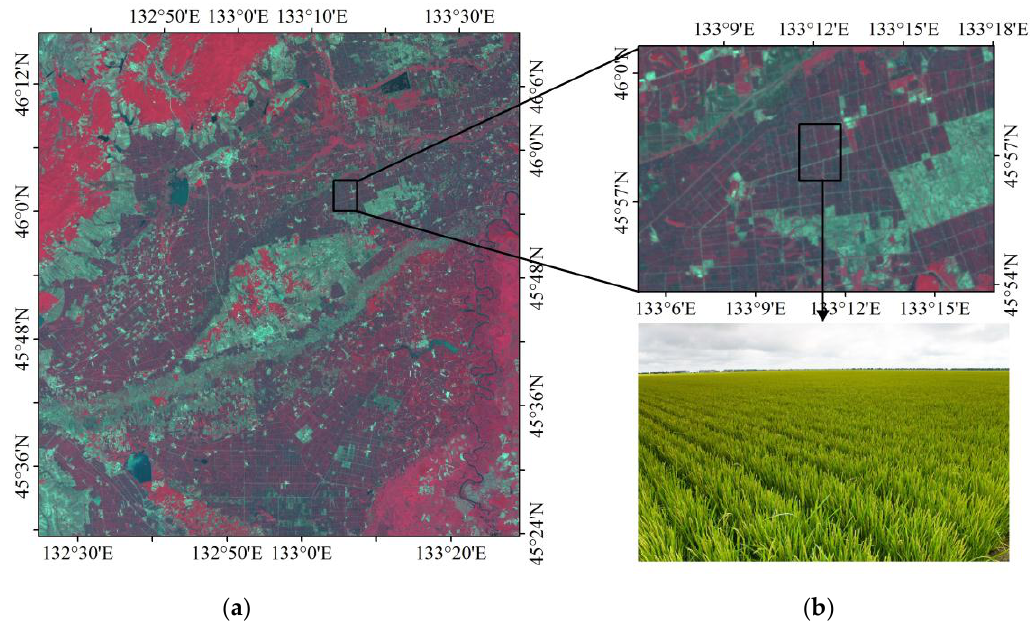
Figure 12. False color image of HJ-1 and a field photo collected from the Sanjiang Plain. ( a ) Sanjiang Plain; ( b ) Cropland.